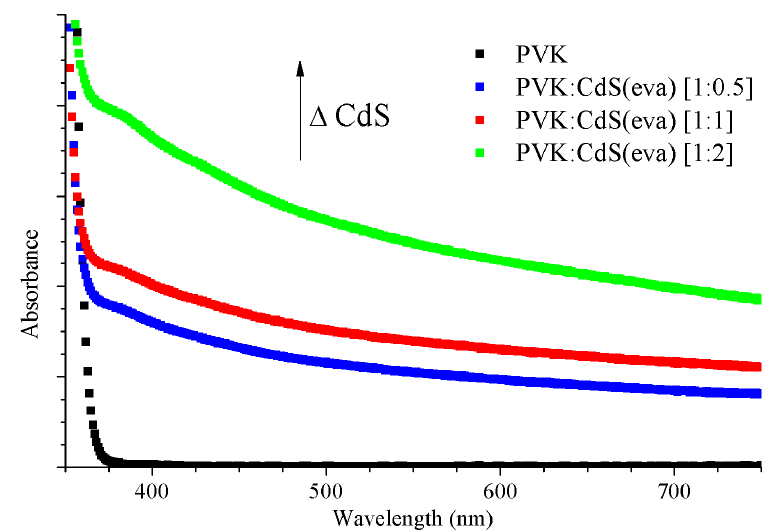
Figure 9. The absorption spectra of the hybrid solutions with increasing CdS content: PVK (black), PVK:CdS [1:0.5] (blue), PVK:CdS [1:1] (red) and PVK:CdS [1:2] (green).